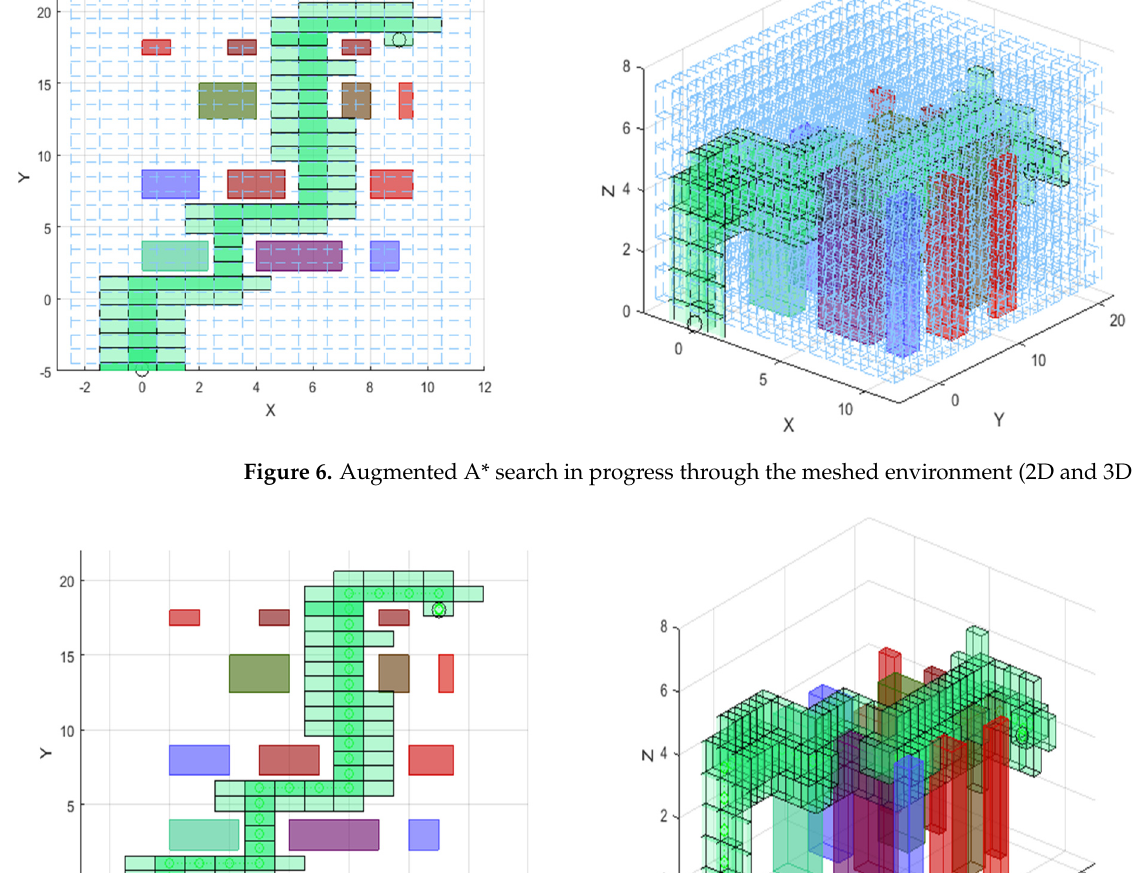
Figure 5. Meshing of the obstacle-cluttered environment (2D and 3D views).